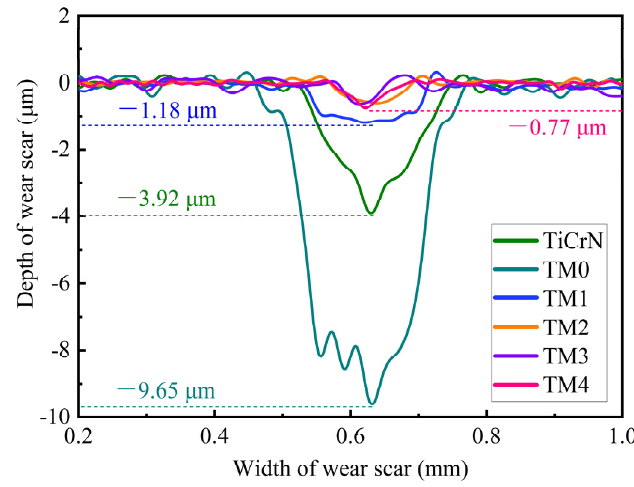
Figure 13. 2D cross-sectional curves of the wear scars.